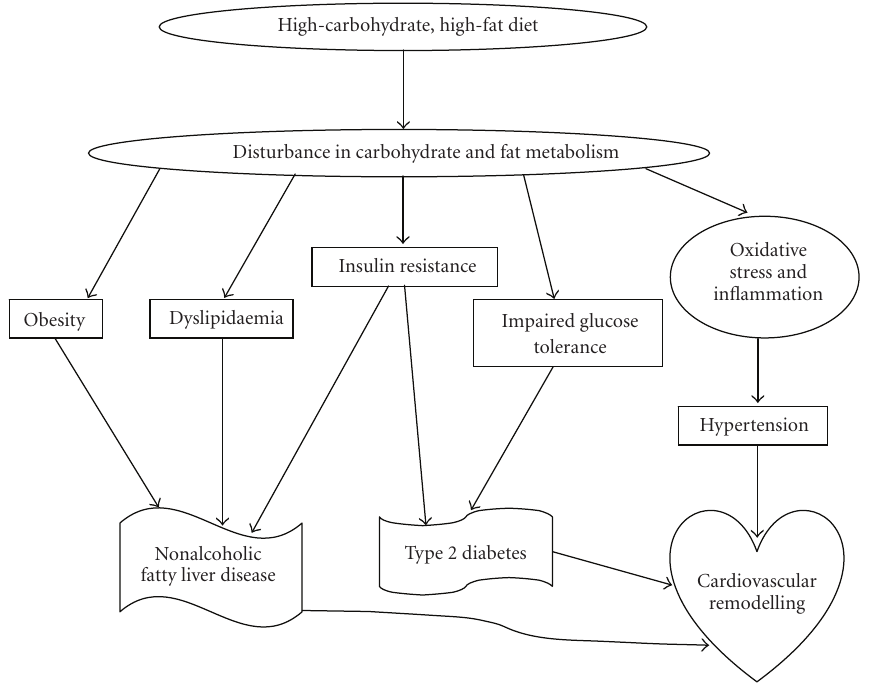
Figure 4: High-carbohydrate, high-fat diet-induced metabolic